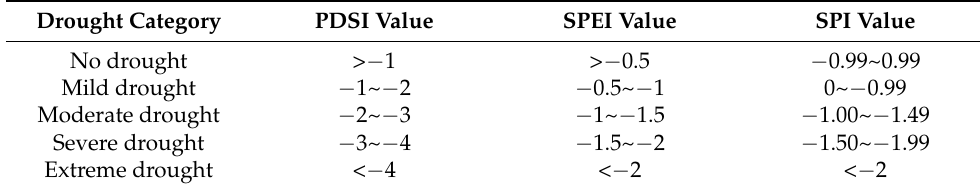
Table 3. The severity and values of drought